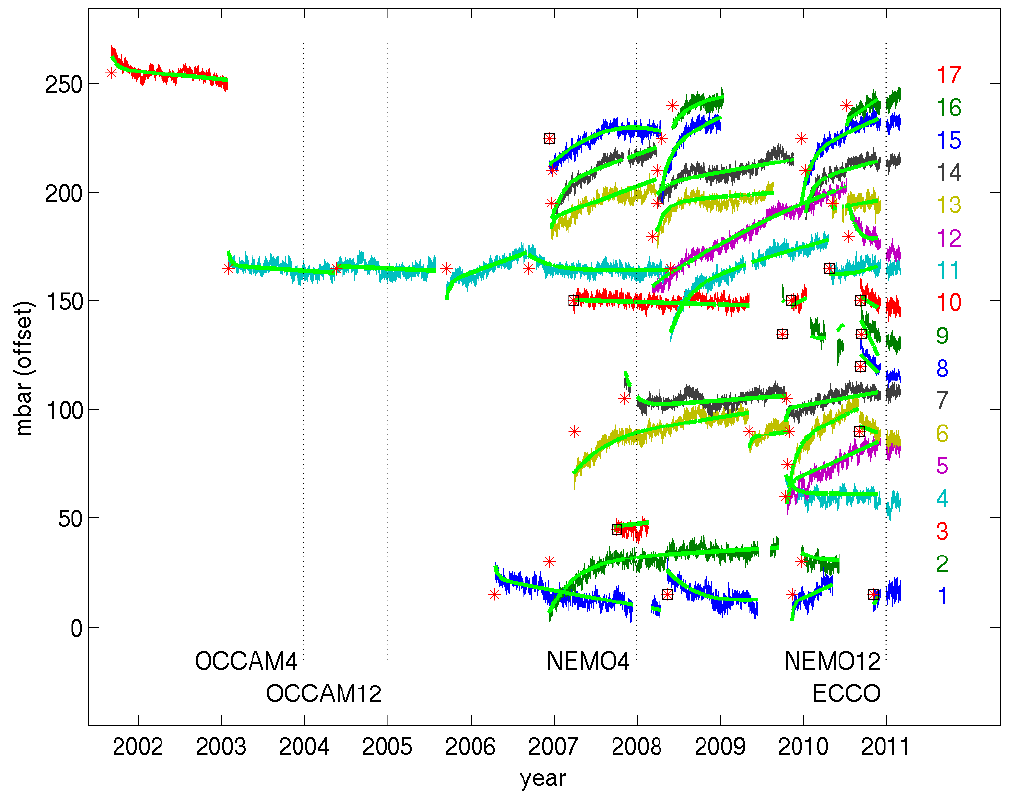
Figure 2. Bottom-pressure data from the 17 test sites (mbar, offset for clarity), following subtraction by least squares fitting of tides with periods of fortnightly and shorter. Stars indicate the start of sensor deployments. There may be gaps in data within deployments. Black squares indicate convergence warnings in the drift fitting. These are not necessarily on the shortest deployments. The overlaid green line shows the sensor drift fitted using the iterative technique on all sites simultaneously. The end dates of the ocean models are also indicated. The y -axis offset between sites is